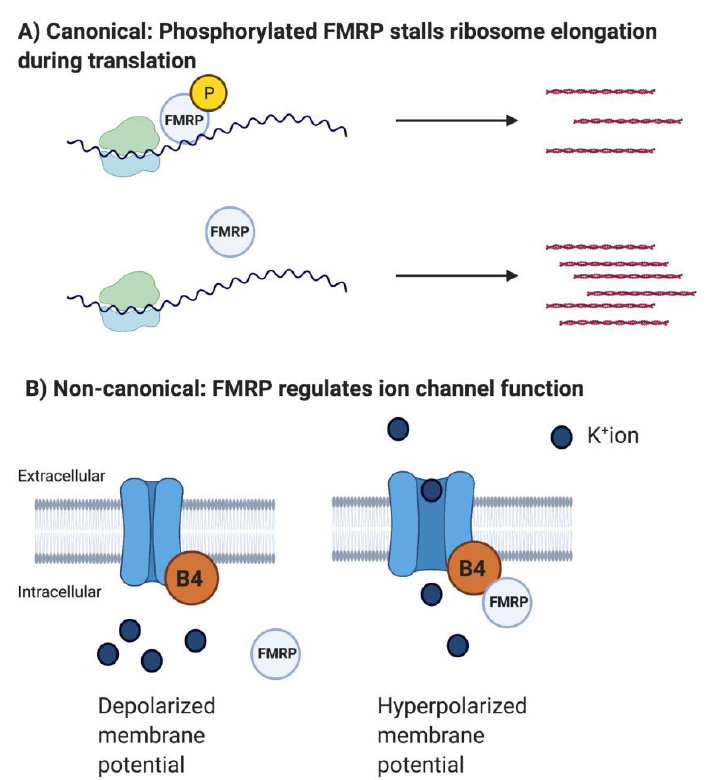
Figure 1. FMRP’s Canonical and Non-Canonical Mechanisms. ( A ) FMRP stalls the elongation of translation (Darnell et al., 2011 [37]). Dephosphorylation of FMRP leads to removal of translational repression, which may allow ribosome elongation and increases total protein synthesis, also shown in Figure 1. ( B ) FMRP regulates protein function directly. Example: FMRP associates with Beta4 (B4) subunits causing opening of the Ca ++ -activated K + BK channel. See Richter et al., 2015 for an in-depth discussion of FMRP’s canonical and non-canonical